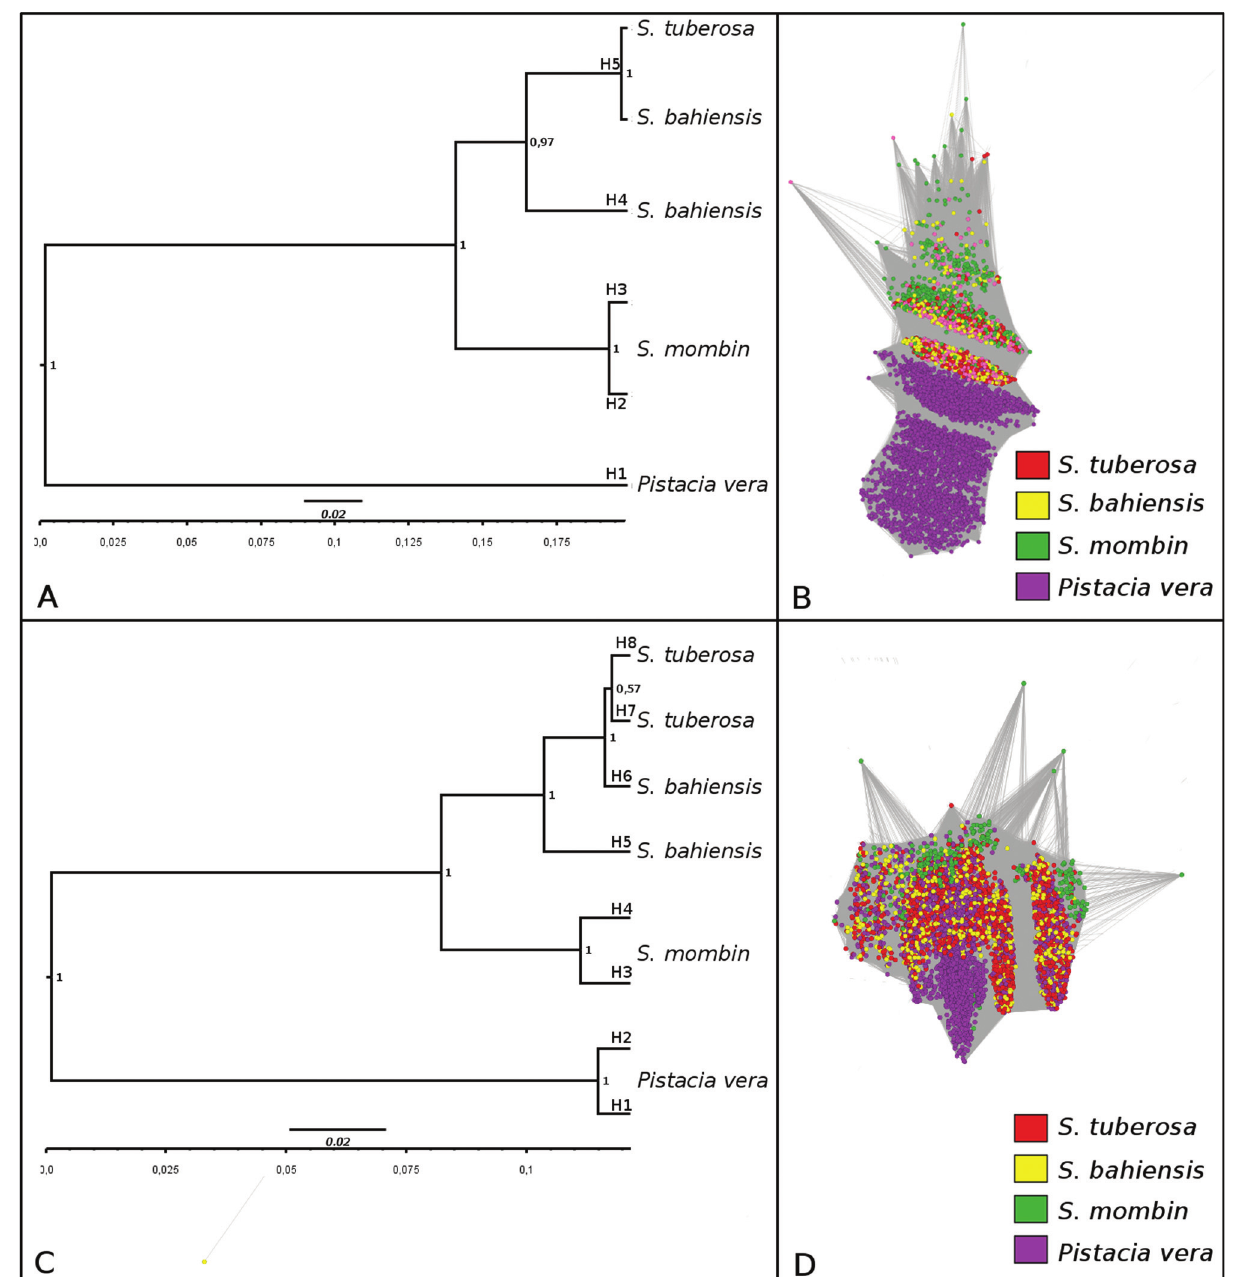
Figure4 -PhylogeneticanalysisofITS1andITS2.PhylogeneticrelationshipsbetweenITS1(A)andITS2(C)usingtheBayesianapproach.Graphicrep- resentation of ITS1 (B) and ITS2 (D), where reads from the species are highlighted in red ( Spondias tuberosa ), yellow ( Spondias bahiensis ), green ( Spondias mombin ), and purple ( Pistacia vera